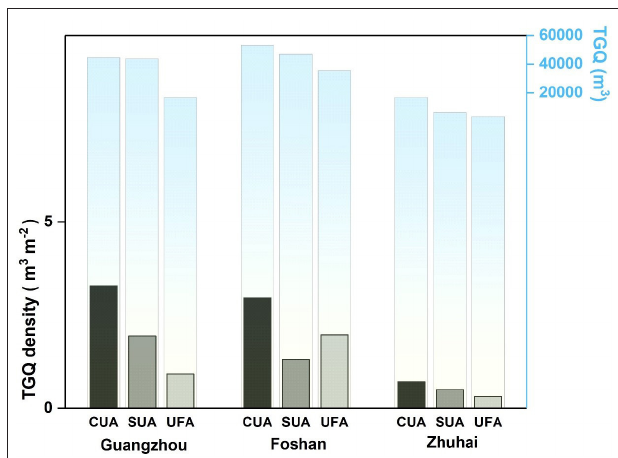
FIGURE 5 | The density of TGQ (m 3 m − 2 ) and the sum of TGQ (m 3 ) in CUA, SUA, and UFA of the three cities, respectively. The bars in dark gray, medium gray, and light gray are the densities of TGQ that follow the left black y-axis while the light blue bars representing the overall TGQ match the right blue